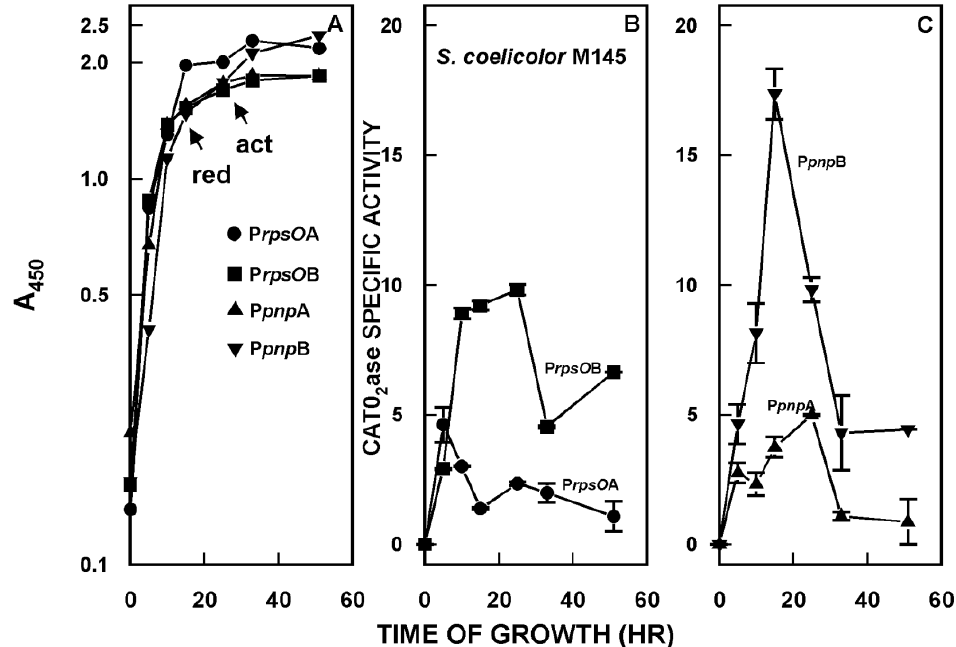
Figure 2. ( A ) Growth of the S. coelicolor strains containing promoter probe constructs. Growth was measured as the increase in optical density at 450 nm. The arrows in the figure indicate the onset of production of two of the secondary metabolites synthesized by S. coelicolor , undecylprodigiosin (red) and actinorhodin (act). ( B ) Catechol dioxygenase (CATO 2 ase) activity of mycelial extracts of S. coelicolor derivatives containing the putative rpsO A and rpsO B promoters, cloned in the promoter probe vector pIPP2 [35]. Mycelium was harvested at the indicated times, disrupted by sonication, and following centrifugation, supernatants were assayed for catechol dioxygenase, as described previously [31,35]. The catechol dioxygenase gene is the reporter in the promoter probe vector [35]. ( C ) CATO 2 ase activities of extracts of strains containing the putative pnp A and pnp B promoters. The results shown are the averages of duplicate assays from two independent experiments ± SEM. This figure is reprinted from Gene , 536, Patricia Bralley, Marcha L. Gatewood, George H. Jones, Transcription of the rpsO–pnp